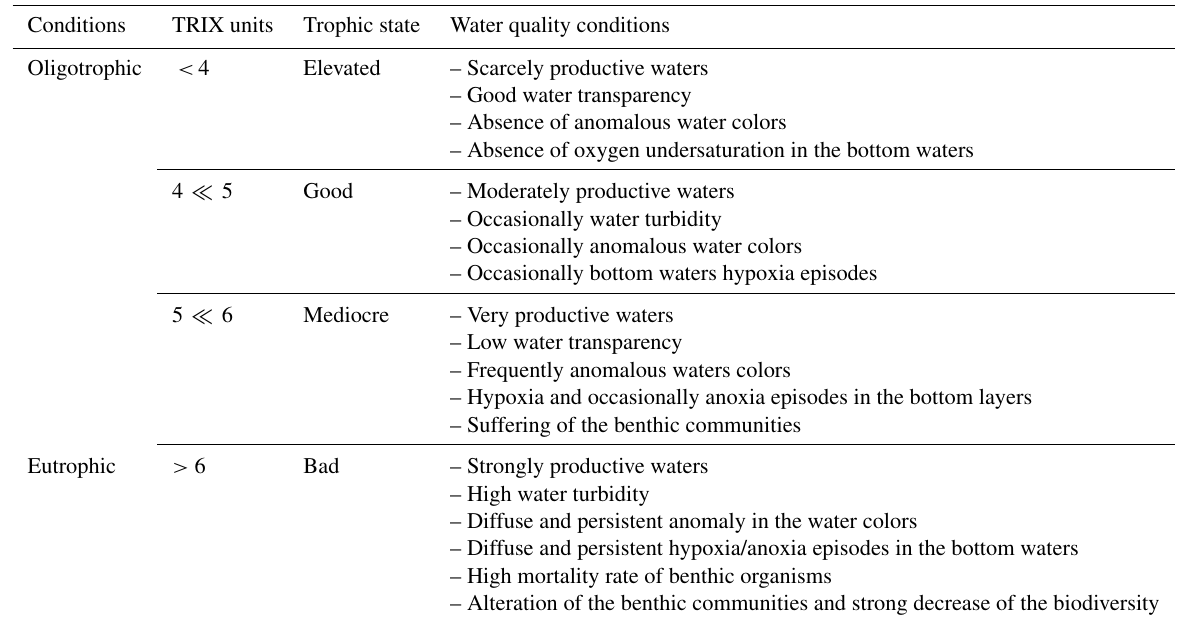
Table 1. Reference values of the trophic index (TRIX) and corresponding water quality and trophic conditions, developed from ARPAE- Daphne Emilia-Romagna (Rinaldi and Giovanardi,